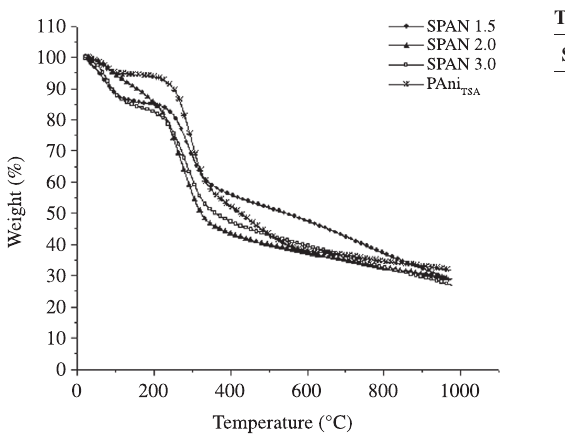
Figure 4. Thermogravimetric analysis of self doped pani (span) and PAni . TSA